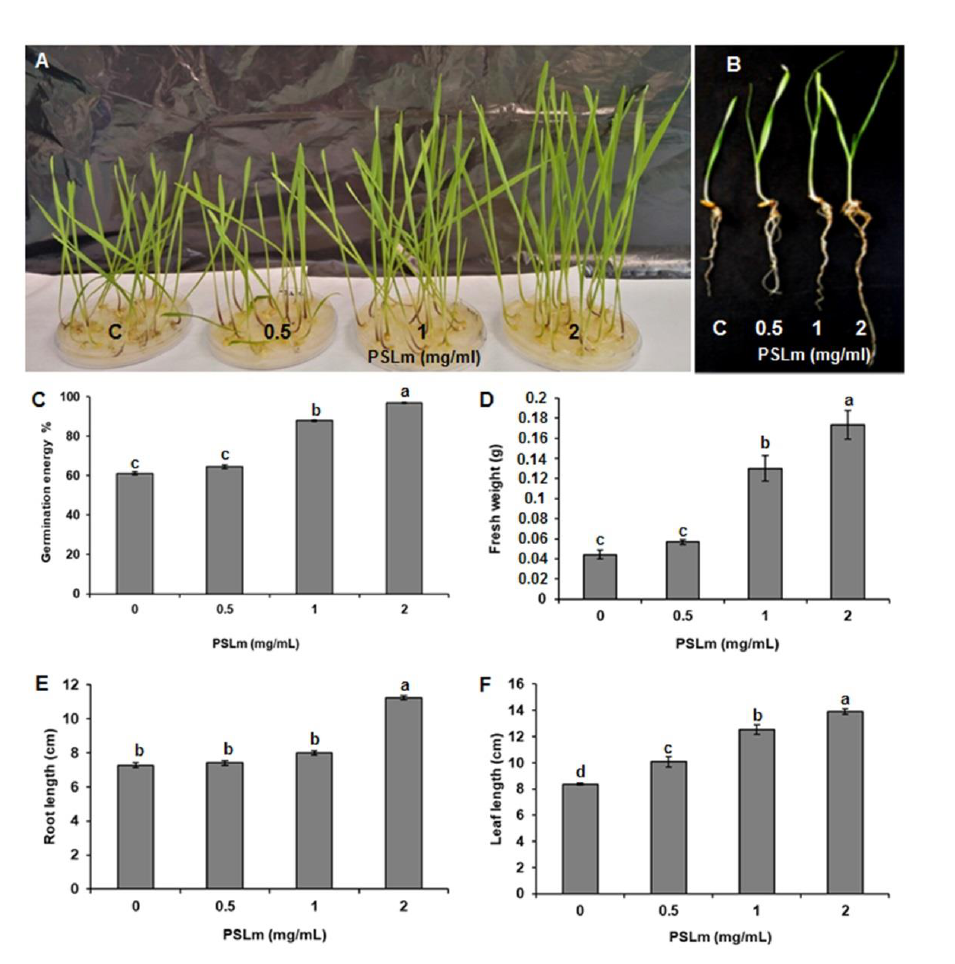
C—Control (untreated seedlings). Values are means ± SE of three biological replicates.